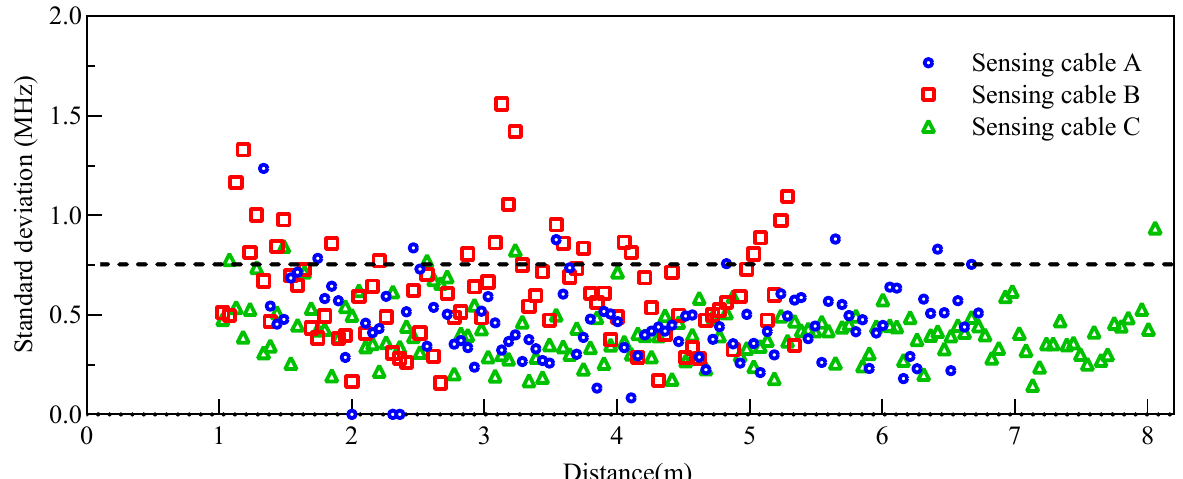
Figure 5. Standard deviation for the BFS along the sensing cables.